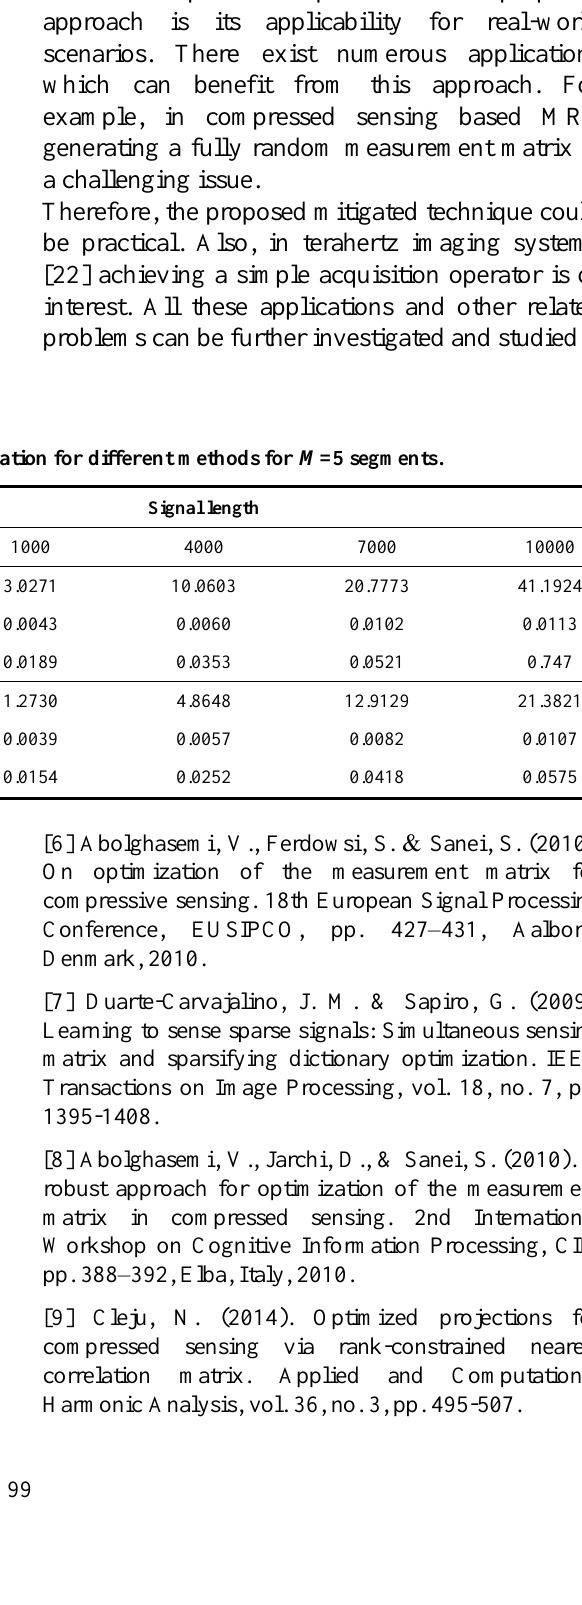
Figure 8. MRI reconstruction results: (a) input image. The reconstructed image using (b) traditional CS, and (c) the proposed method.